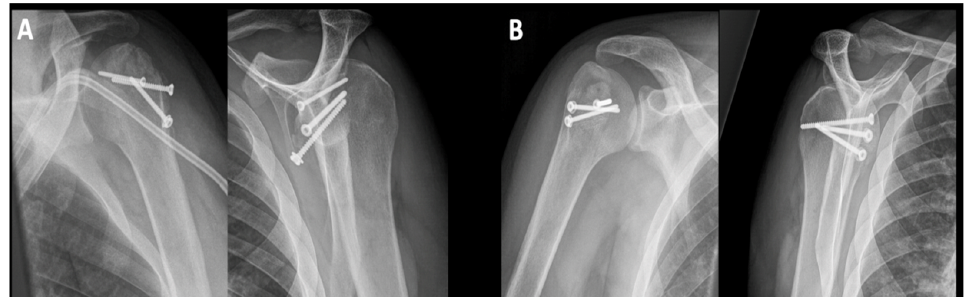
Figure 3. Postoperative imaging of the patient from Figures 1 and 2; ( A ) left shoulder: 3 ‐ month post ‐ operative X ‐ rays of the left proximal humerus: no pain, no displacement of the screws (the opacifi ‐ cation on the a.p. X ‐ ray is a dialysis catheter); ( B ) right shoulder: 3 ‐ month postoperative X ‐ rays of the left proximal humerus: no pain, no displacement of the screws.